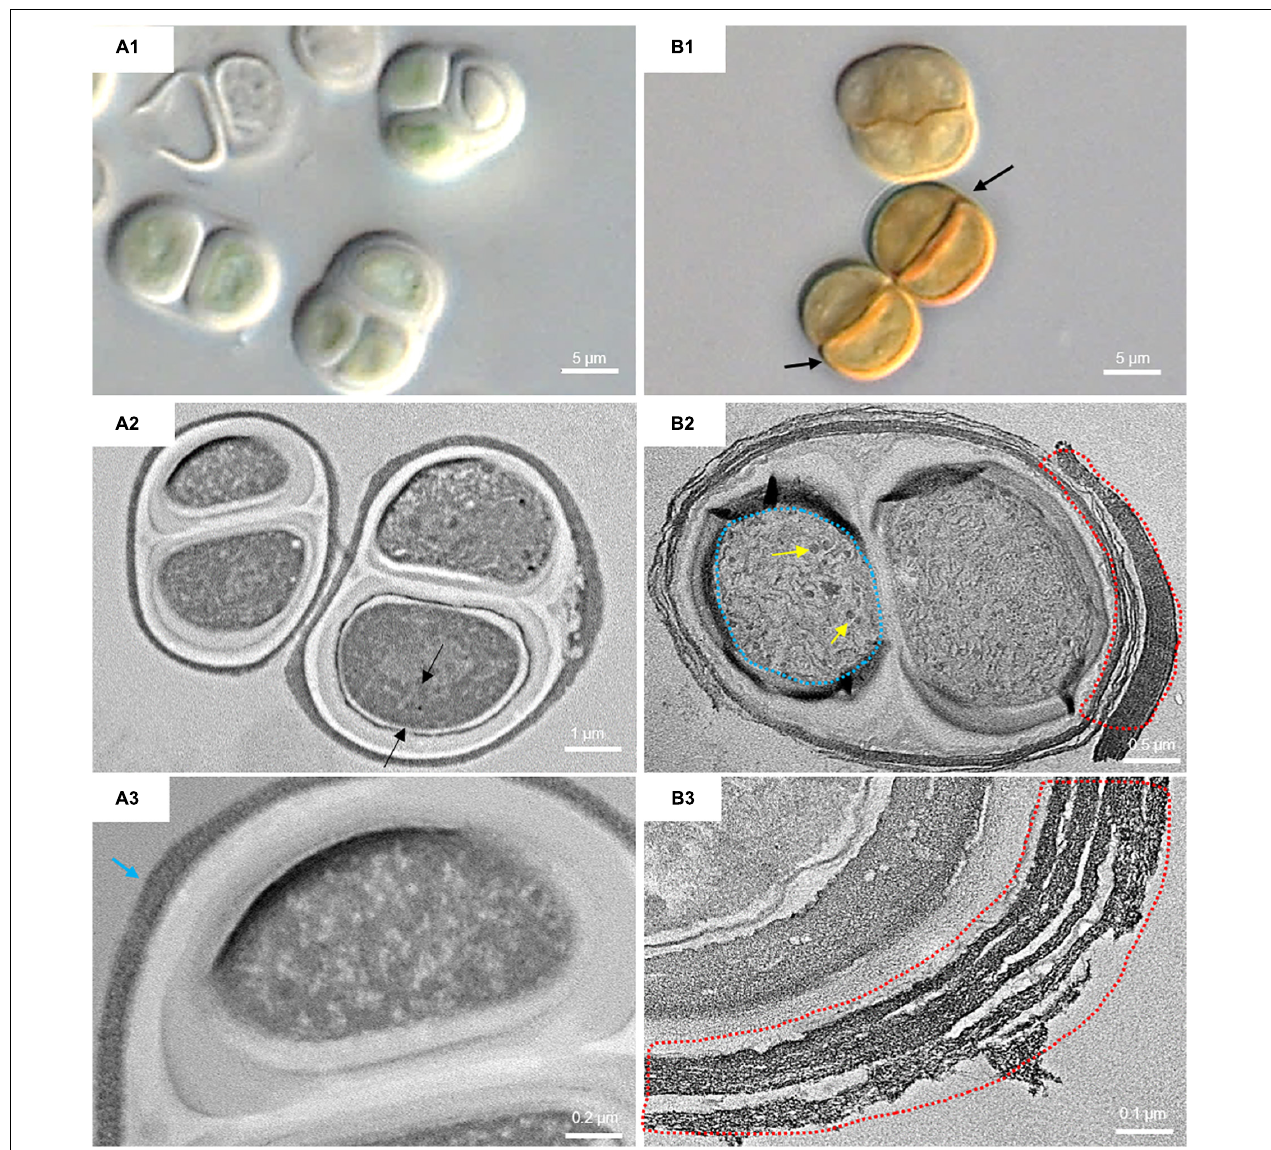
FIGURE 7 | DIC microscopy and TEM images from UAM816. Series A: Cells and aggregates at the beginning of the experiment. (A1) DIC image of green UAM816 cells. (A2) TEM image showing the thylakoid arrangement (between black arrows) in PAR-only irradiated cells. (A3) TEM image of UAM816 cells showing a slightly more developed outermost fibrous layer (blue arrow). Series B: Cells and aggregates at their maximum scytonemin content after 9 days of irradiation with UVR + PAR. (B1) DIC image of brown UAM816 cells with a higher scytonemin content on the outer region. (B2) TEM image of cells showing disaggregation of the thylakoid membranes (blue dotted line), glycogen granules [dark spots (yellow arrows)] and a high electron-dense outermost fibrous layer (red dotted line). (B3) TEM image of the outer part of the cell revealing a highly fibrous outermost layer (red dotted